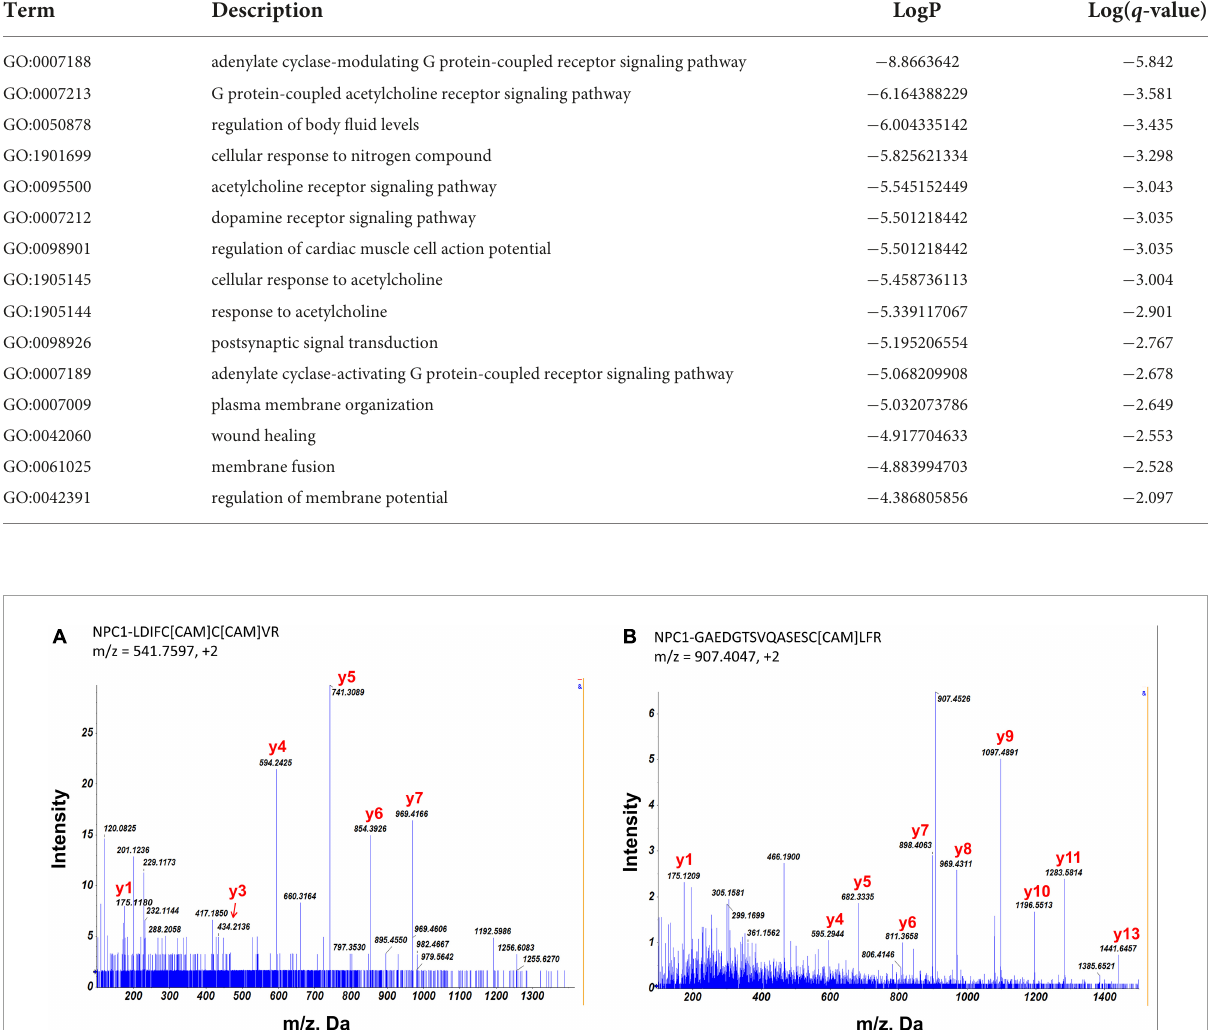
TABLE 3 Top GO processes that were overrepresented by proteins with potential 2-BP in-sensitive palmitoylation sites. Term